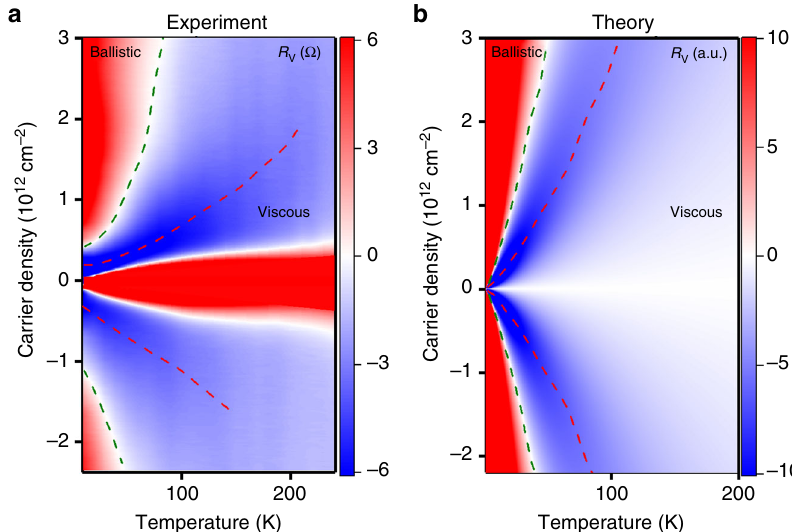
Fig. 2 Vicinity resistance R v as a function of carrier density and temperature. The dashed green line indicates zero resistance. Dashed red lines: minima in the resistance. a Experiment: R v ( n , T ) for bilayer graphene. The central red region indicates the density range around the CNP where our hydrodynamic analysis is inapplicable. b Theory: resistance obtained by solving the kinetic equation. The key features in both panels: sign reversal at quasiballistic-to- hydrodynamic transition, the maximal negative signal at the onset of the viscous regime, and a slow decay of the signal at higher